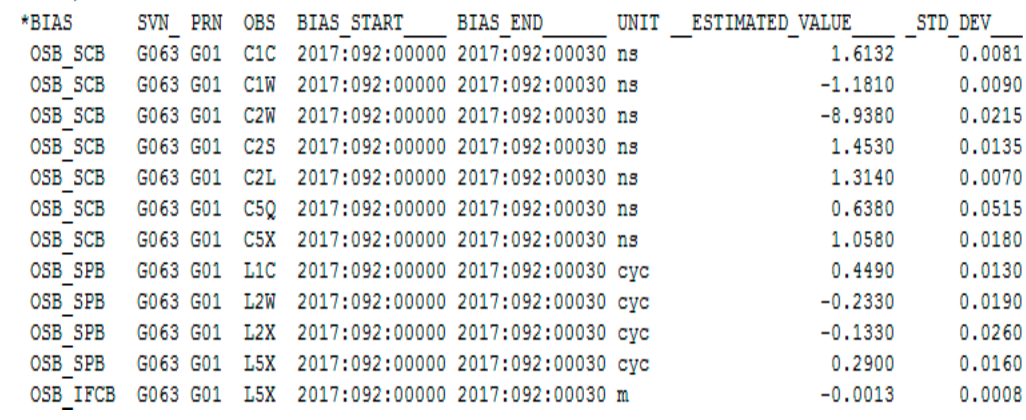
Figure A1 RMS of positioning errors at different sessions in the east, north and up components for Figure A1. RMS of positioning errors at di ff erent sessions in the east, north and up components for UDUC-PPP AR with or without IFCB corrections. UDUC-PPP AR with or without IFCB